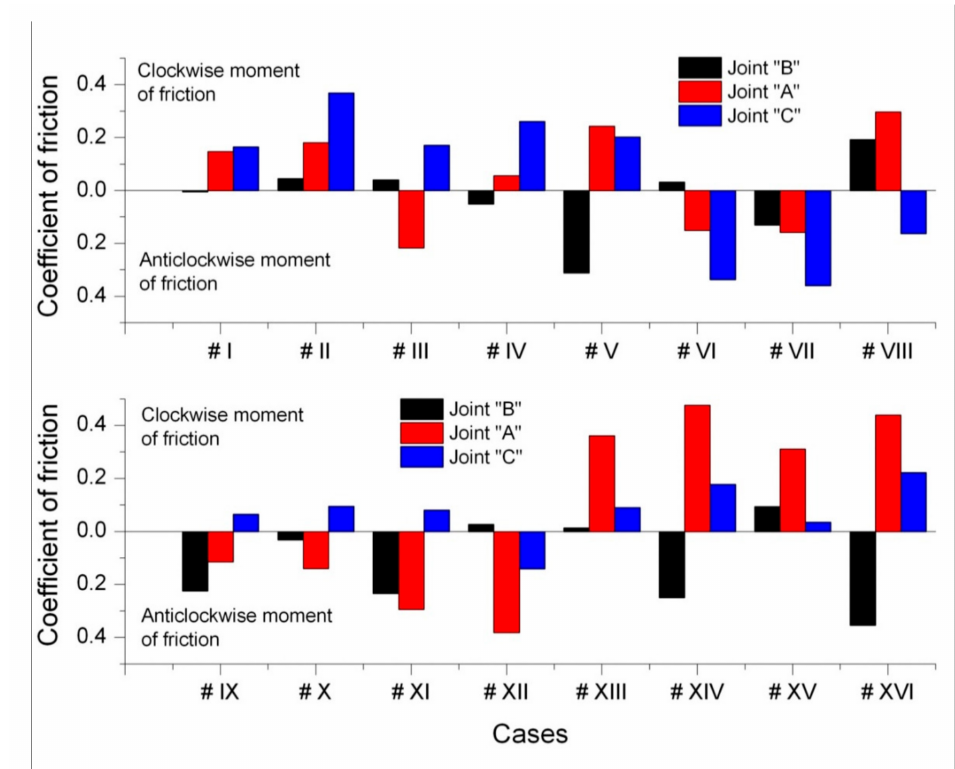
Figure 16. Coefficient of friction for case #I to case #XVI of quasi-uniform strain